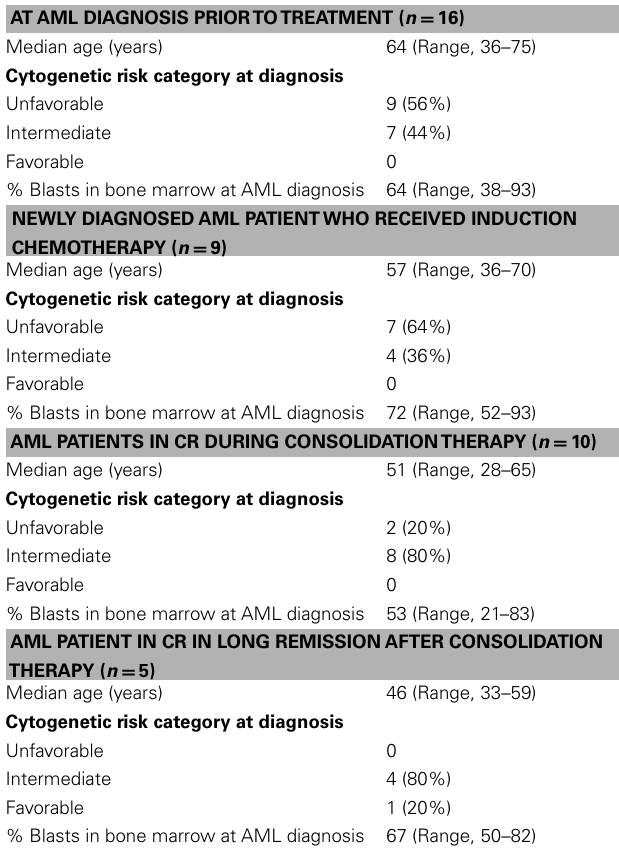
Table 1 | Characteristics ofAML patients included in this